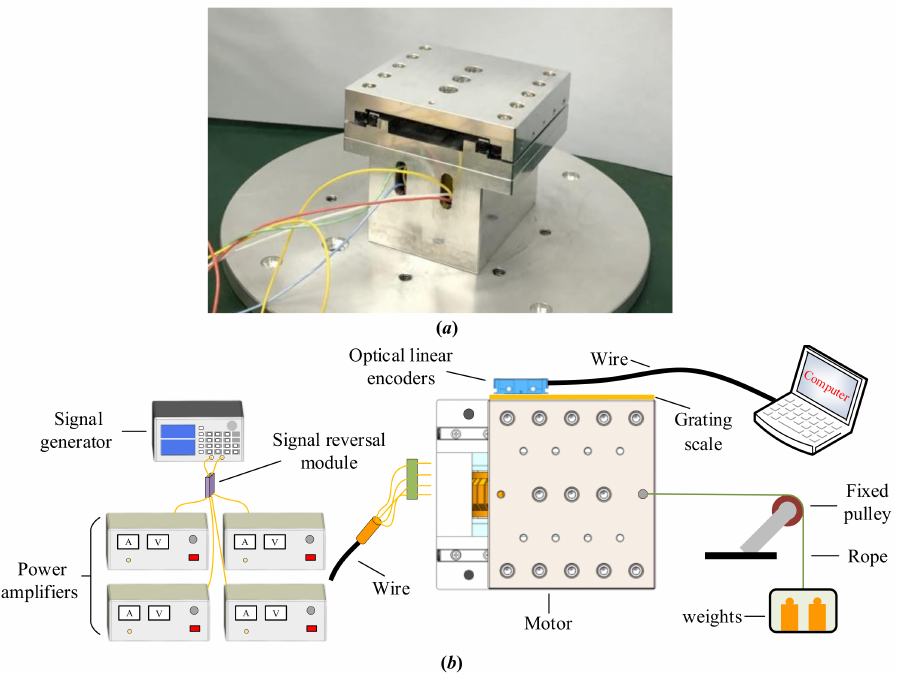
Figure 12. The experimental platform: ( a ) a prototype of the proposed LUSM; ( b ) an experimental tested system.